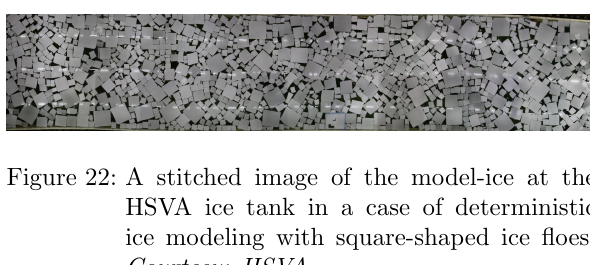
Figure 21: Histogram of the pixel values of the grayscale image, and the chosen threshold (red line) between “ice pixels” and “water pixels”. Courtesy: Qin Zhang